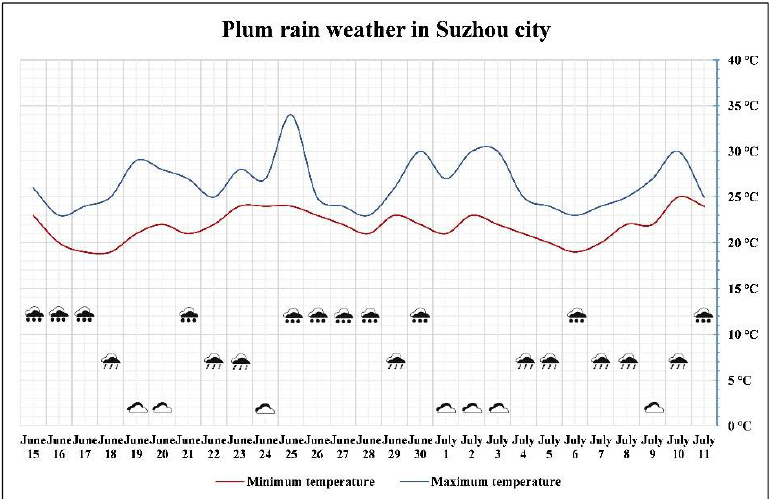
Figure 1. Plum rain weather in Suzhou City (low reaches the Yangtze River of China).